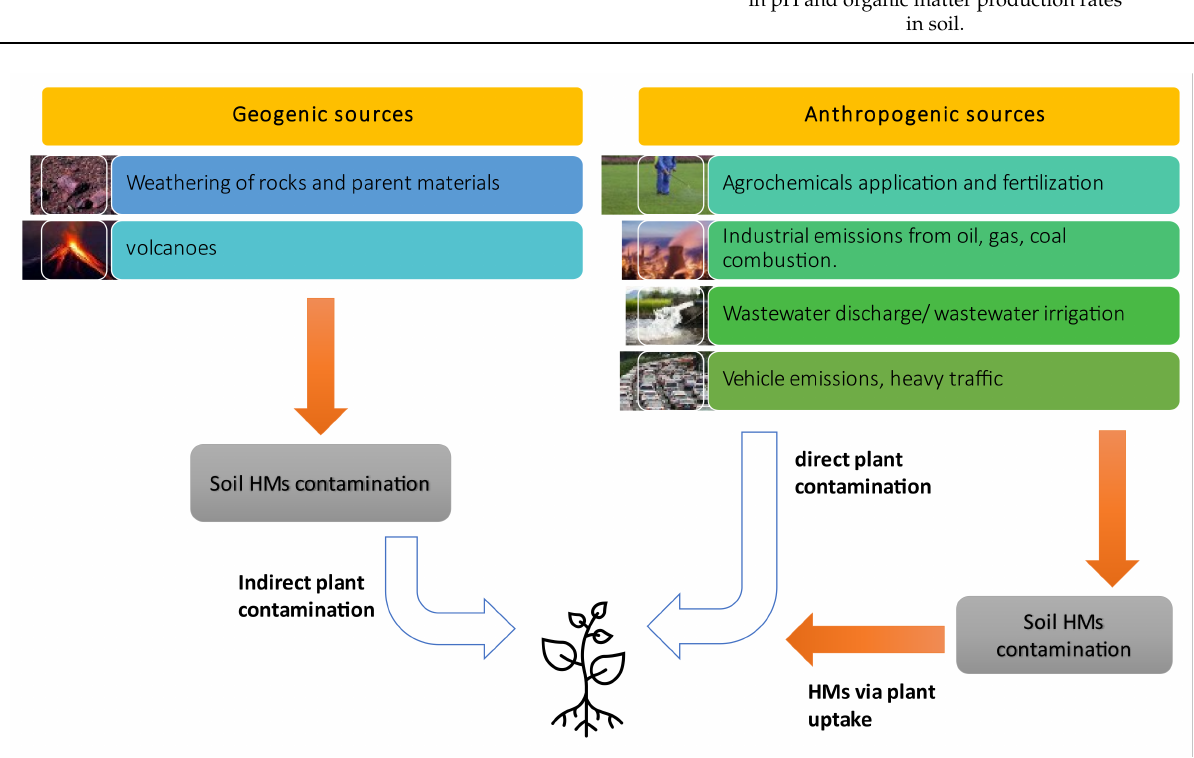
Figure 2. Principal origins of cadmium and lead contamination in soil-plant